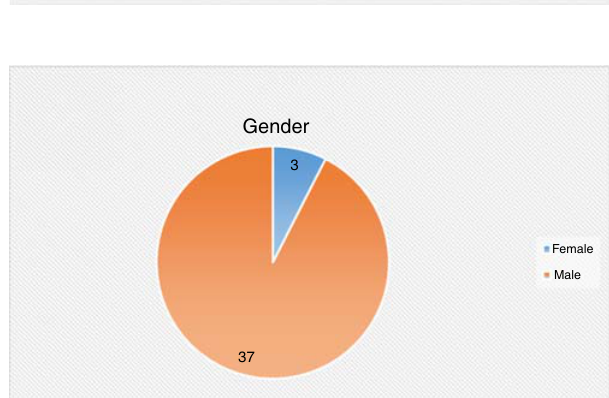
Figure 7. Language skills of